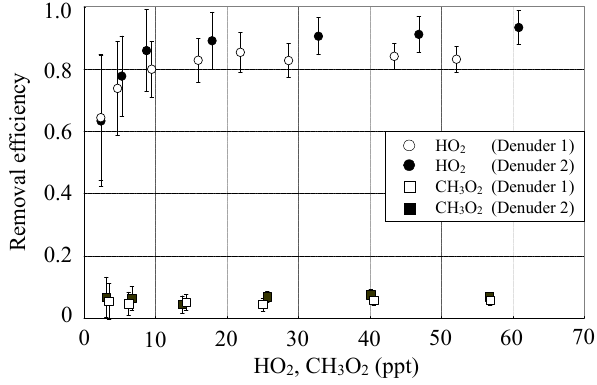
Fig. 5. Removal efficiency α for two different long denuders as a function of initial HO 2 radical concentration: Denuder 2 is twice as long as Denuder